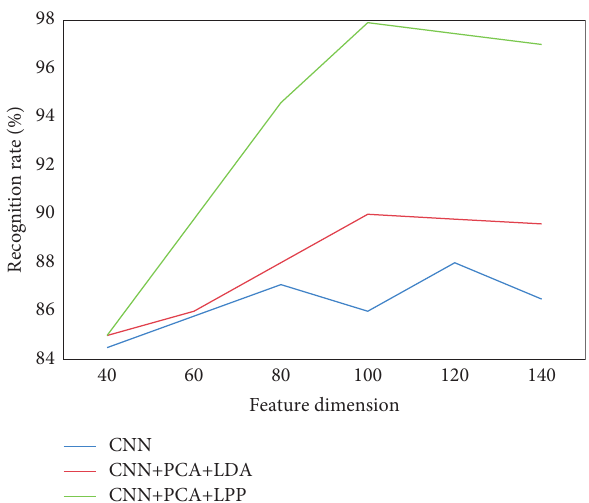
Figure 6: Comparison of discrimination rates in different feature dimensions. Table 4: Recognition rate and time efficiency under the basic model. Algorithm model